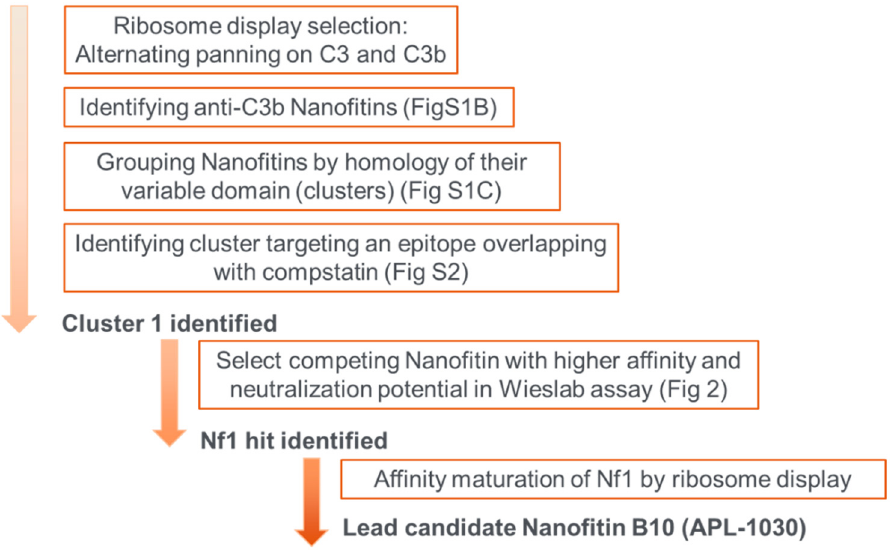
Figure A4. Schematic overview of selection rounds and subsequent steps to obtain the lead candi- dates.